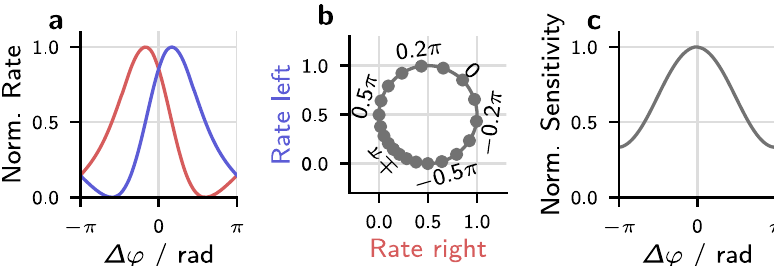
Fig. 4 Visualization of the impact of non-sinusoidal IPD-rate functions. a IPD-rate functions that exhibit a steeper slope towards zero IPD. b Plotting the fi ring rates of the left hemisphere against the rates in the right hemisphere results in a plot similar to the complex plane plot shown in Fig. 1g. Markers indicate the location of IPDs evenly spaced by 0.1/ π . c The uneven spacing of IPDs on the circle shown in b results in the sensitivity to changes in IPD to depend on IPD. Shown is the sensitivity normalized to its value at